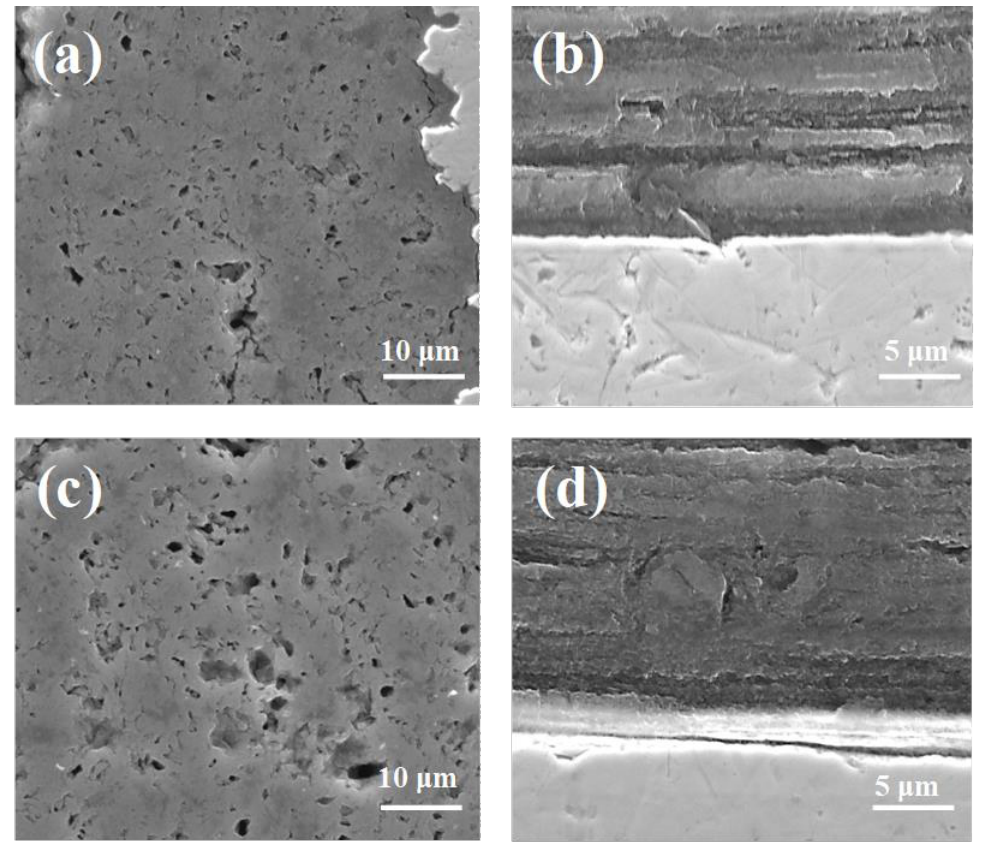
Figure 5. SEM images of 10% SiC-doped MgB 2 wires of 0.63 mm diameter: ( a ) cross-section and ( b ) longitudinal section for sample L (1 GPa, 725 °C, 15 min) and ( c ) cross-section and ( d ) longitudinal section for sample M (1 GPa, 700 °C, 25 min). The metal sheath is the Nb barrier.